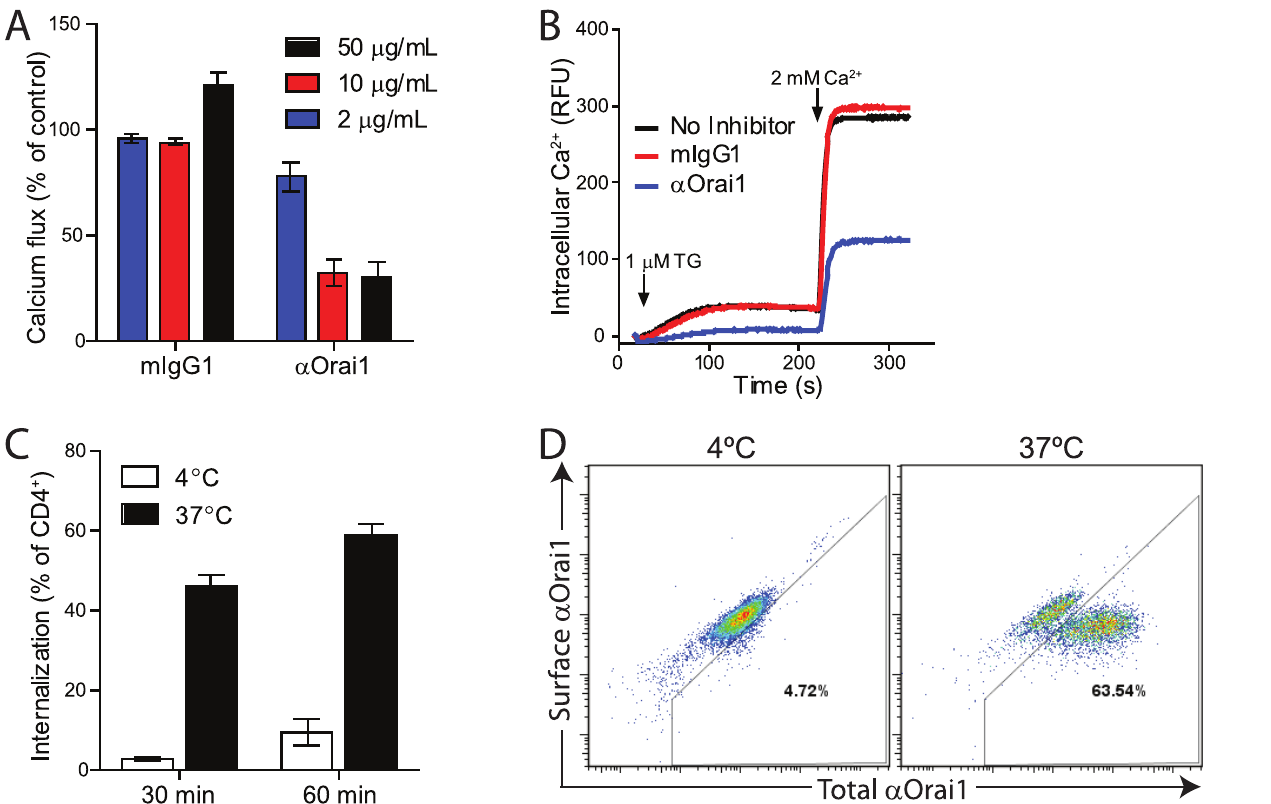
Figure 3. Anti-Orai1 antibody inhibits calcium flux and induces internalization in T cells. A ) Inhibition of thapsigargin-induced calcium flux in Jurkat cells with a Orai1. Data is calculated as percentage of D RFU following calcium influx in the absence of antibody addition. B ) Representative trace of thaspigargin (TG)-induced calcium influx in Jurkat cells treated with 50 m g/mL a Orai1 or mIgG1 control. C ) a Orai1 internalization in purified human CD4 + cells was measured following incubation at 37 u C by flow cytometry using 2 m g/mL a Orai1-AF647 and cell surface detection with biotinylated anti-Cy5 followed by streptavidin-BV421. Samples at 4 u C were analyzed in parallel as negative controls for internalization. Data is calculated as percentage of total CD4 + cells and is the average of three donors. D ) Representative flow cytometry plots of surface bound a Orai1 compared to total internalized and surface a Orai1. Panels A and B are representative of three independent experiments and panels C and D are representative of two